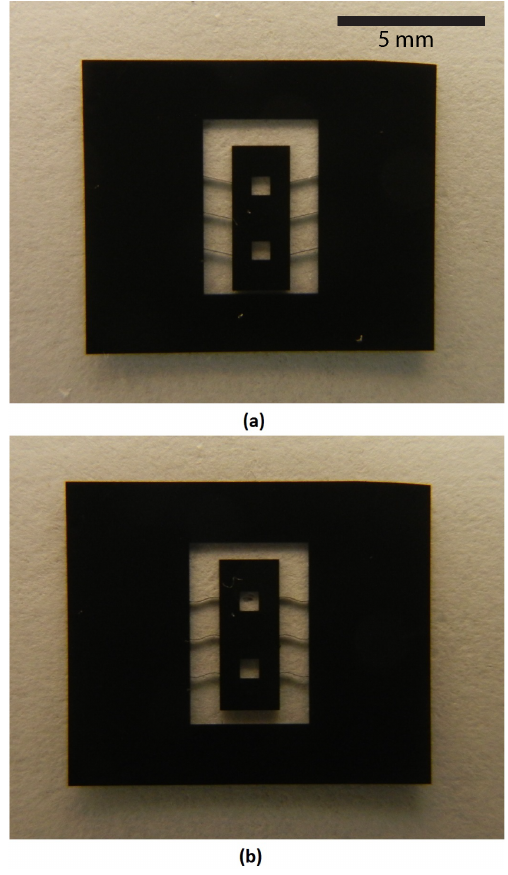
Figure 5. (a) 14 ◦ accelerometer design in its fabricated position. (b) Accelerometer switched to its second stable position.